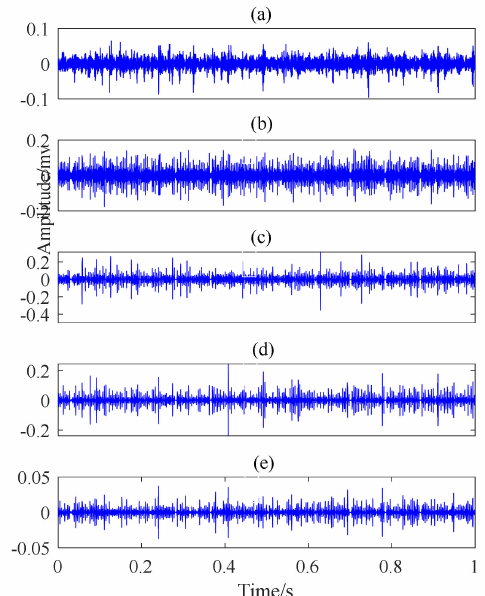
Figure 27. The IMFs of the collected signal of the bearing with 3 mm outer race fault processed by the Improved EWT method: ( a ) IMF1; ( b ) IMF2; ( c ) IMF3; ( d ) IMF4; ( e )